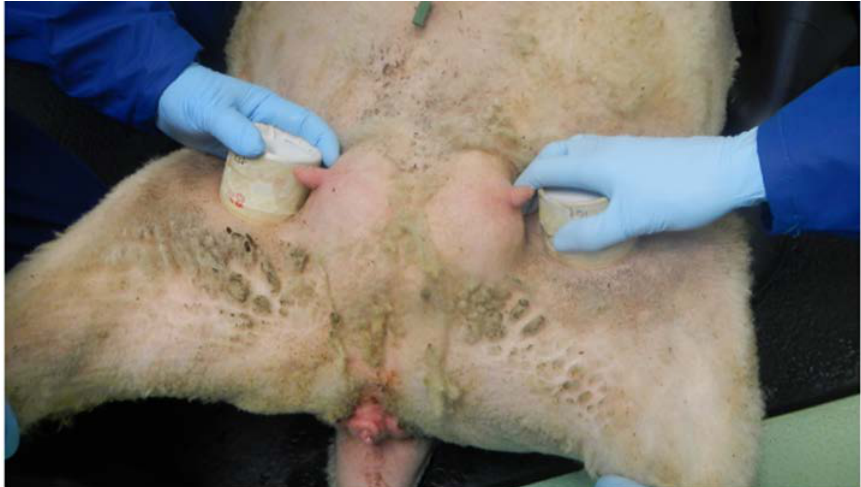
Figure 1. Bluetongue virus (BTV) infection of sheep via blood feeding of infected Culicoides sonorensis . C. sonorensis were infected with BTV by IT inoculation and following an incubation period of 5–6 days at 25 °C allowed to feed directly on the inner thigh of a sheep as described in the methodology. Each sheep was simultaneously exposed to one pot containing C. sonorensis infected with BTV serotype